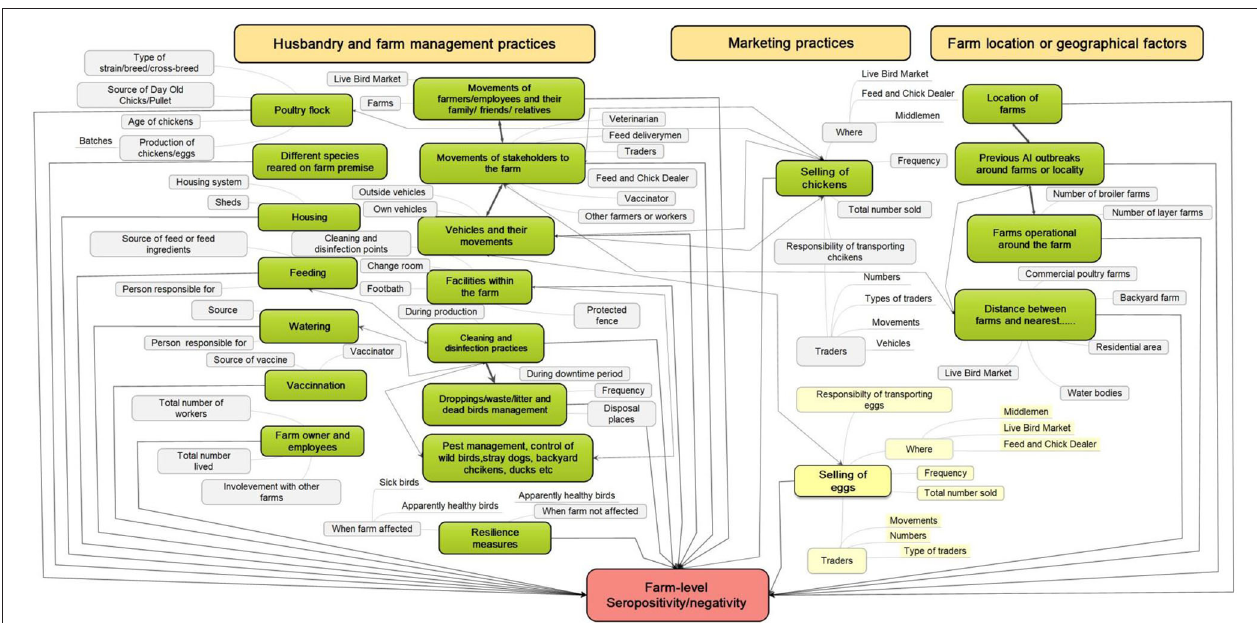
FIGURE 1 | Hypothesized causal pathways for farm-level risk factors associated with avian influenza infection on the commercial broiler and layer chicken farms in Bangladesh. The red box represents the outcome (farm-level seropositivity) in the risk factor analysis, green boxes represent individual risk factors with gray boxes indicating additional categories/levels within the risk factor. The yellow boxes represent risk factors specific to layer farms. Orange boxes represent themes or categories under which risk factors can be combined. The causal pathways were used to inform the development of questions used in the interviews and to guide the inclusion of potential confounders and interactions in the final multivariable